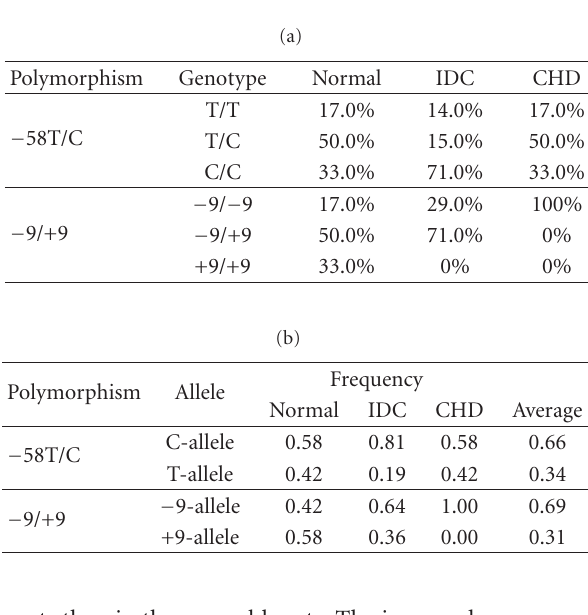
Table 2: Genotypic and allelic frequencies of two BK-2R gene poly- morphisms in normal and failing human hearts. The genotypic and allelic frequencies for two common BK-2R gene polymorphisms were calculated in both normal and failing human